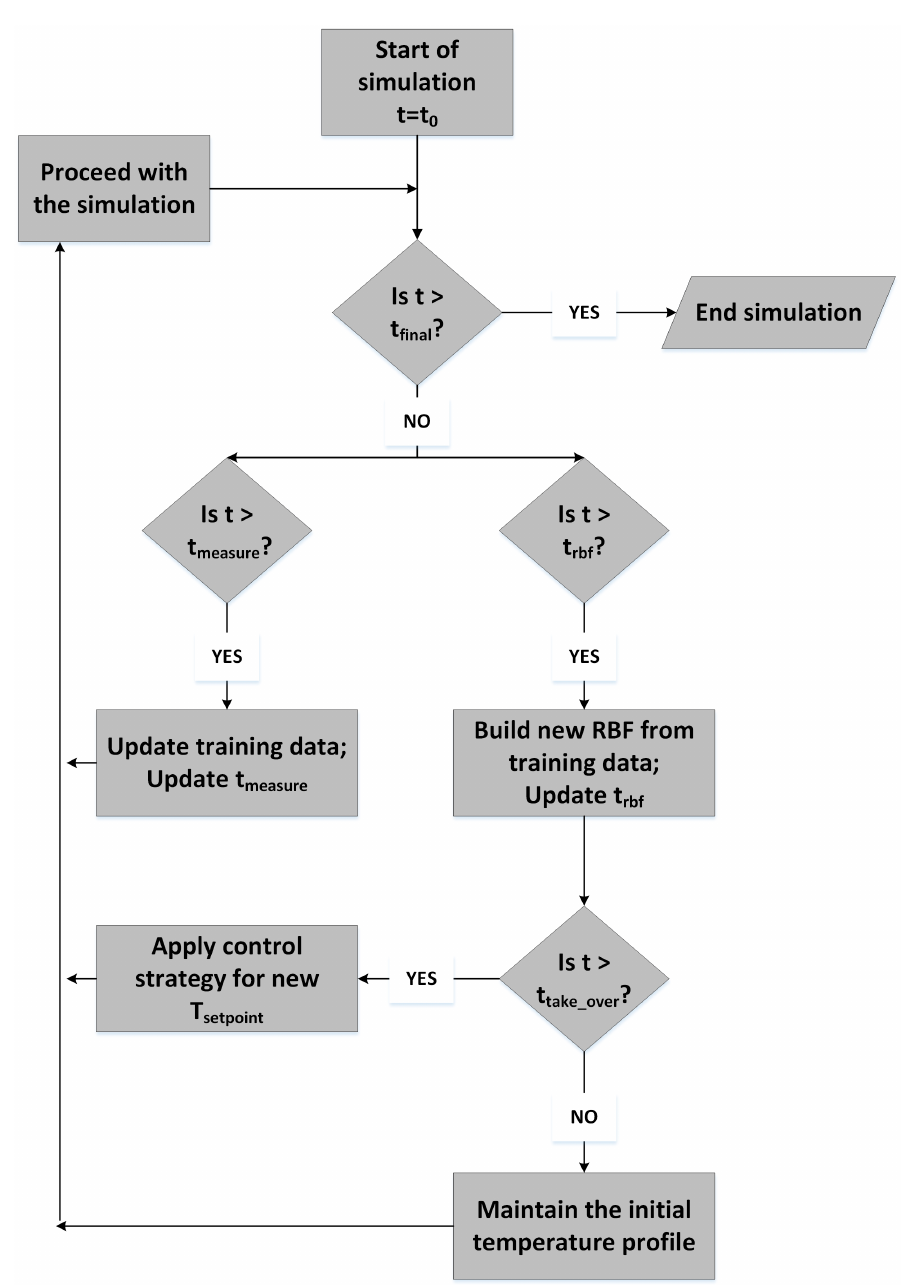
Figure 2. Workflow used to apply the radial basis functions (RBF) Growing Window methodology to